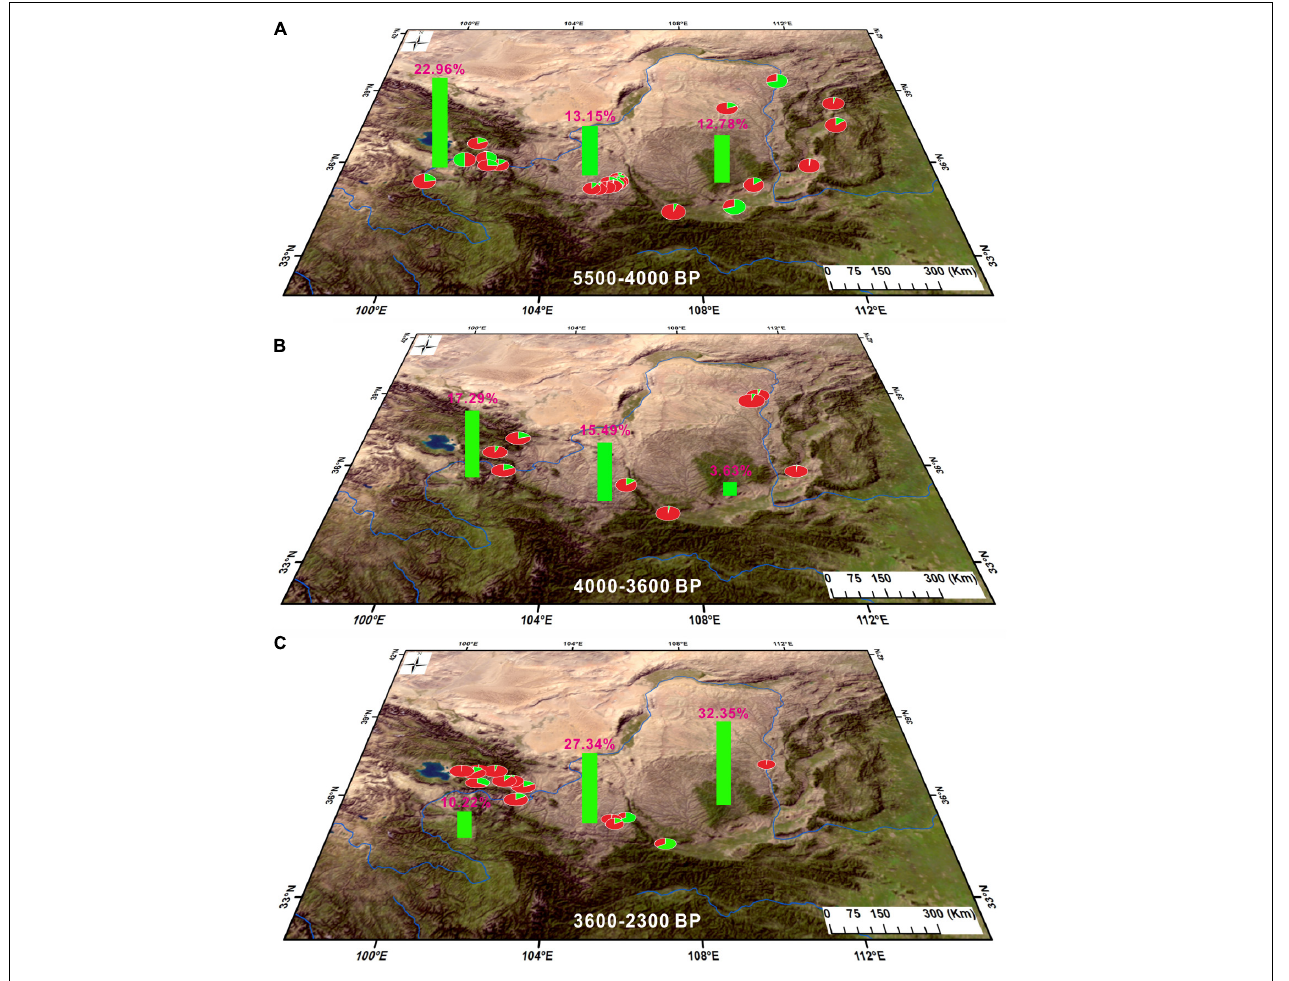
FIGURE 7 | Spatiotemporal comparisons of woody assemblages (including the proportions of fruit trees and other woody plants) in the NETP and Chinese Loess Plateau dated to the periods 5,500–4,000 BP, 4,000–3,600 BP, and 3,600–2,300 BP. Green indicates the proportion of fruit trees and red indicates the proportion of other